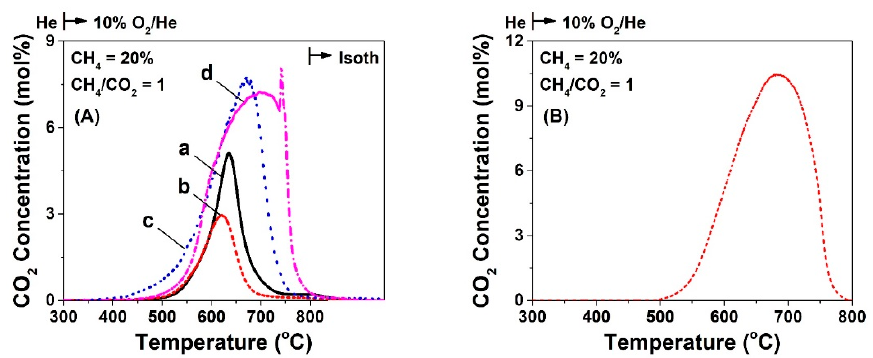
Figure 3. Transient response curves of CO 2 concentration obtained during TPO of carbon formed after ( A ) 12 h of DRM (20% CH 4 /20% CO 2 /He; 50 NmL min − 1 ; GHSV ∼ 30,000 h − 1 ) at 750 °C over 5 wt% Ni/CeO 2 prepared